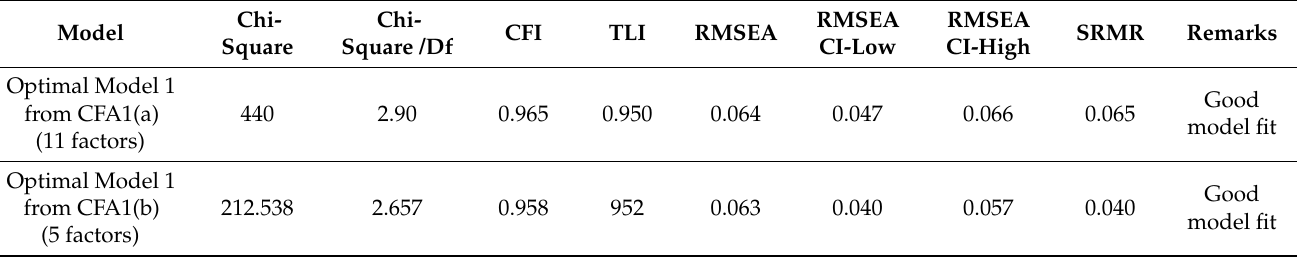
Table 4. CFA Crosschecked Fit Statistic for 11 Factors for Training in the Specific Domain and 5 in the General Domain, in the Second Sample ( n =